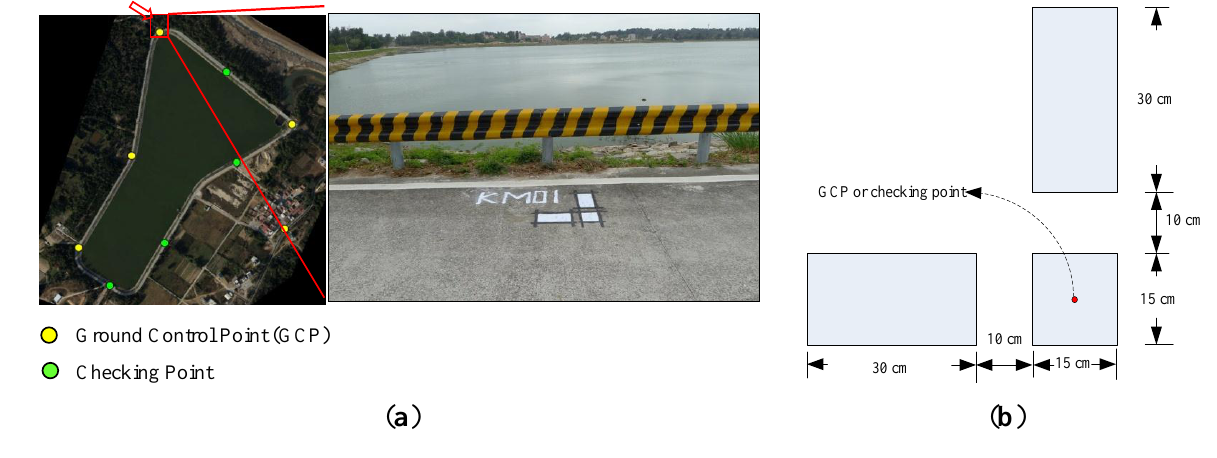
Figure 4. ( a ) Proposed locations of GCPs and checking points; ( b ) Style of GCPs or checking points.